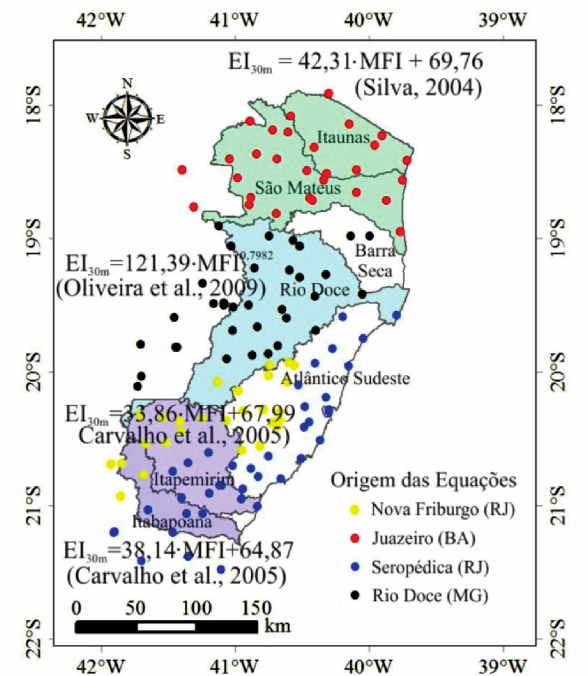
Figura 1. Principais bacias hidrográficas do Estado do Espírito Santo, distribuição espacial dos postos pluviométricos empregados no estudo e respectivas equações EI 30m x MFI aplicadas e respectivos